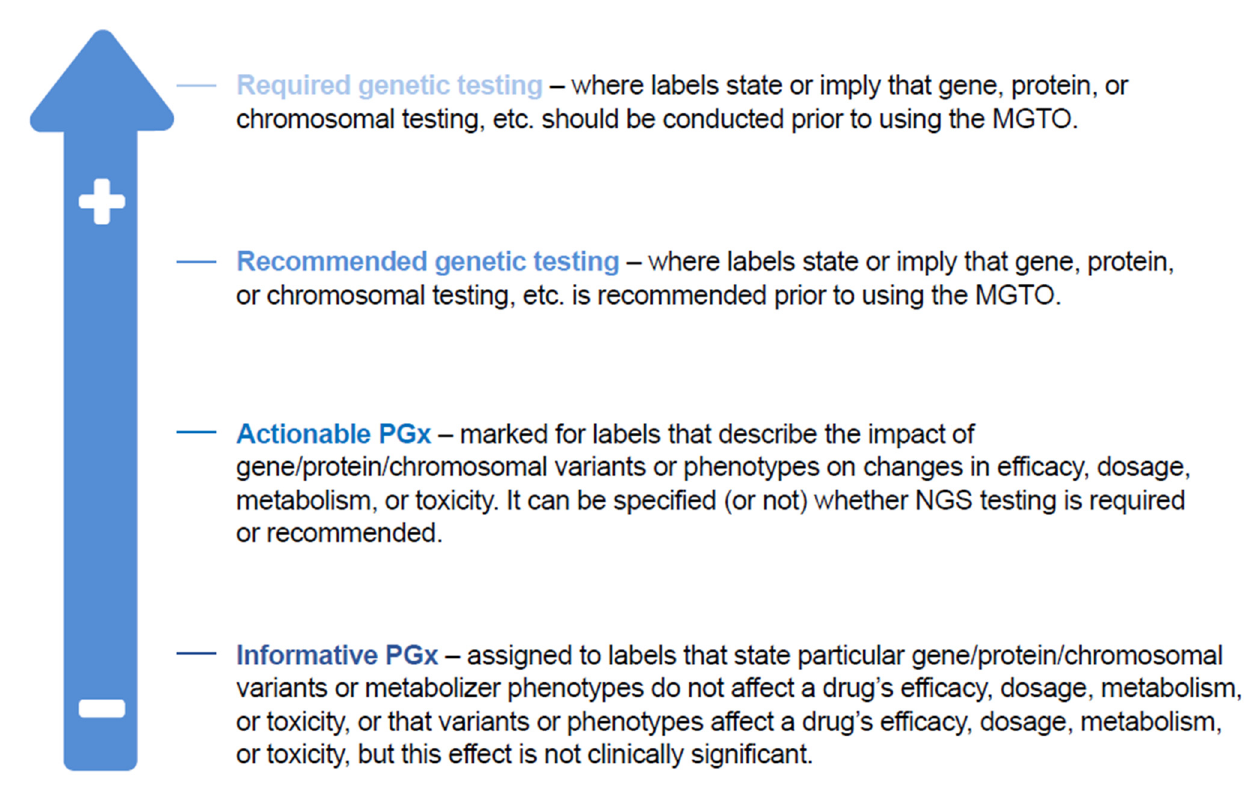
Figure 4. PharmGKB classification of PGx information associated with specific gene–drug combina- tion. MGTO, molecularly guided treatment option; PGx, pharmacogenomics. Adapted from Kim J. A., et al., 2021 [81].